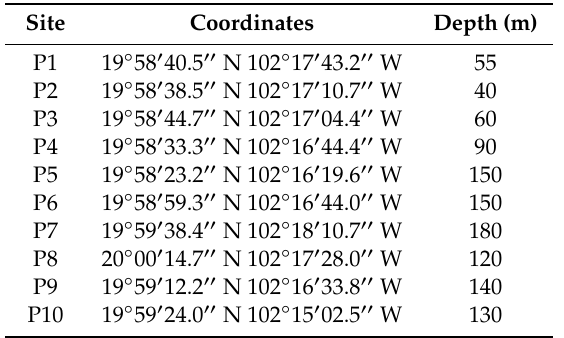
Table 2. Location and depth of the studied wells in the urban area of Zamora, Michoac á n.